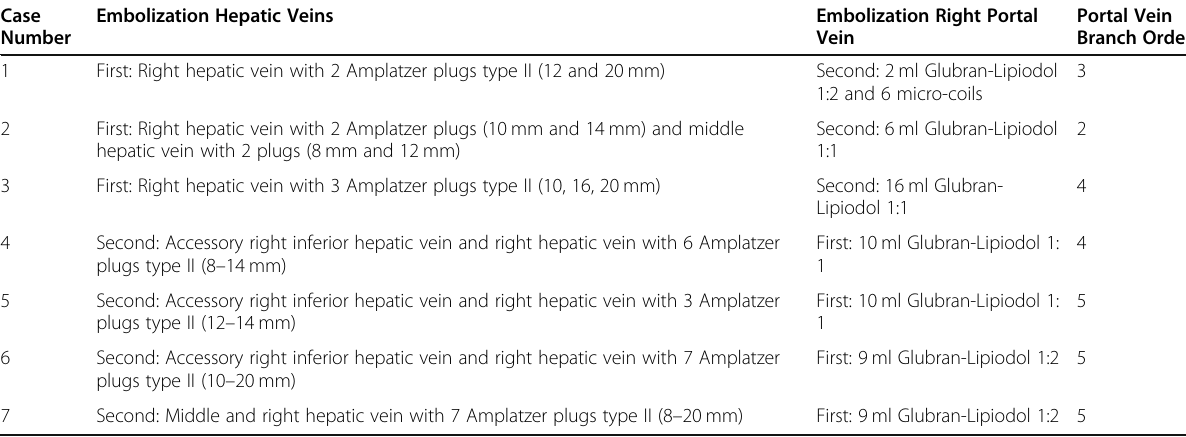
Table 2 Technical details about embolization material, order of embolization and glue penetration